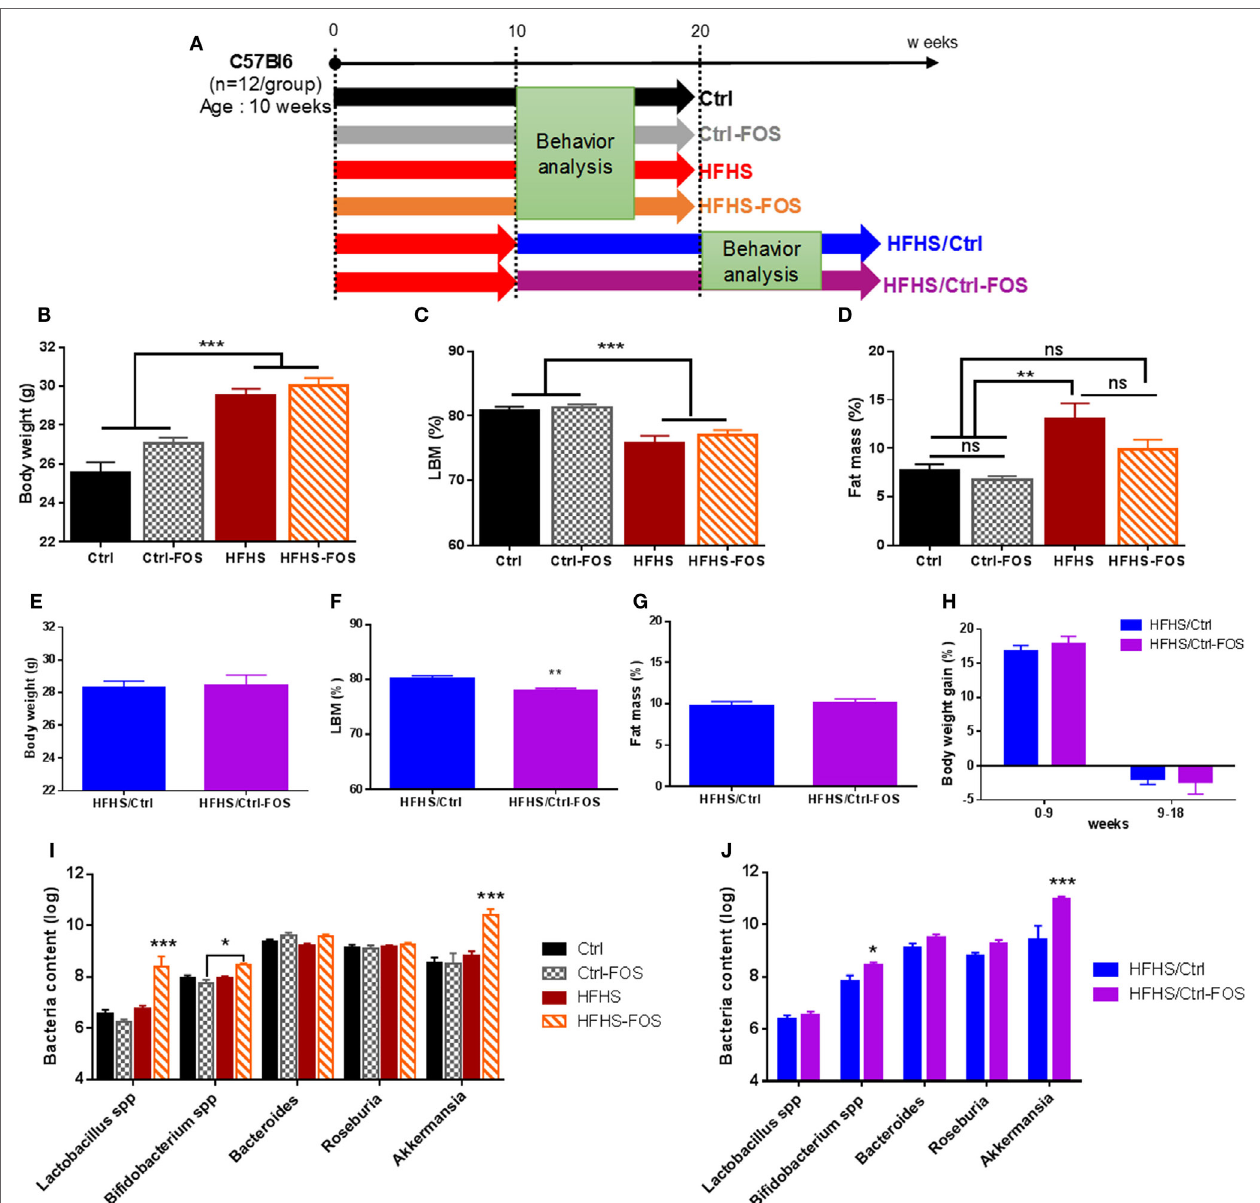
FigUre 1 | (a) . Experimental design of diet manipulation in which mice were fed, respectively, regular chow (Ctrl, black), high-fat high-sucrose diet (HFHS, red), or diet enriched in fructo-oligosaccharides (FOS) (Ctrl-FOS, gray and HFHS-FOS, orange) in a protective approach. Two additional groups were fed an HFHS and switched onto either regular chow diet (HFHS/Ctrl, blue) or regular chow enriched in FOS (HFHS/Ctrl-FOS, purple). (B–h) Body weight and body composition evolution during diet manipulation in the six different groups. (B,e) Body weight evolution, (c,D,F,g) body composition in (c,F) lean body mass (LBM) and (D,g) fat body mass in Ctrl (black), Ctrl-FOS (gray), HFHS (red), HFHS-FOS (orange), HFHS/Ctrl (blue), and HFHS/Ctrl-FOS (purple). (i,J) Targeted metagenomics analysis of cecum bacterial content in animal fed Ctrl (black), Ctrl-FOS (gray), HFHS (red), and HFHS-FOS (orange) and (J) after switch on Ctrl or Ctrl-FOS diet in HFHS/Ctrl (blue) and HFHS/Ctrl-FOS (purple). Data are expressed as mean ± SEM of 12 mice in each group. Significant differences from a one-way ANOVA (B–D) , paired t- test (F) and a two-way ANOVA (i,J) , Bonferroni Post hoc test are shown (* P < 0.005, ** P < 0.001, *** P <